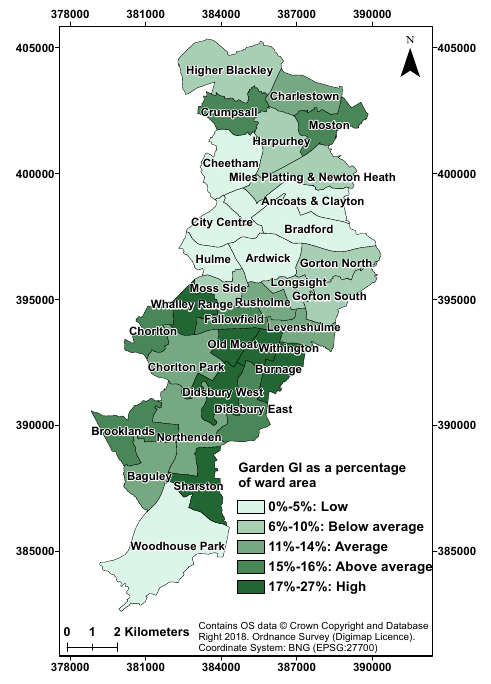
Figure 8. Garden green infrastructure (GI) as a percentage of ward area (classified by quantiles).